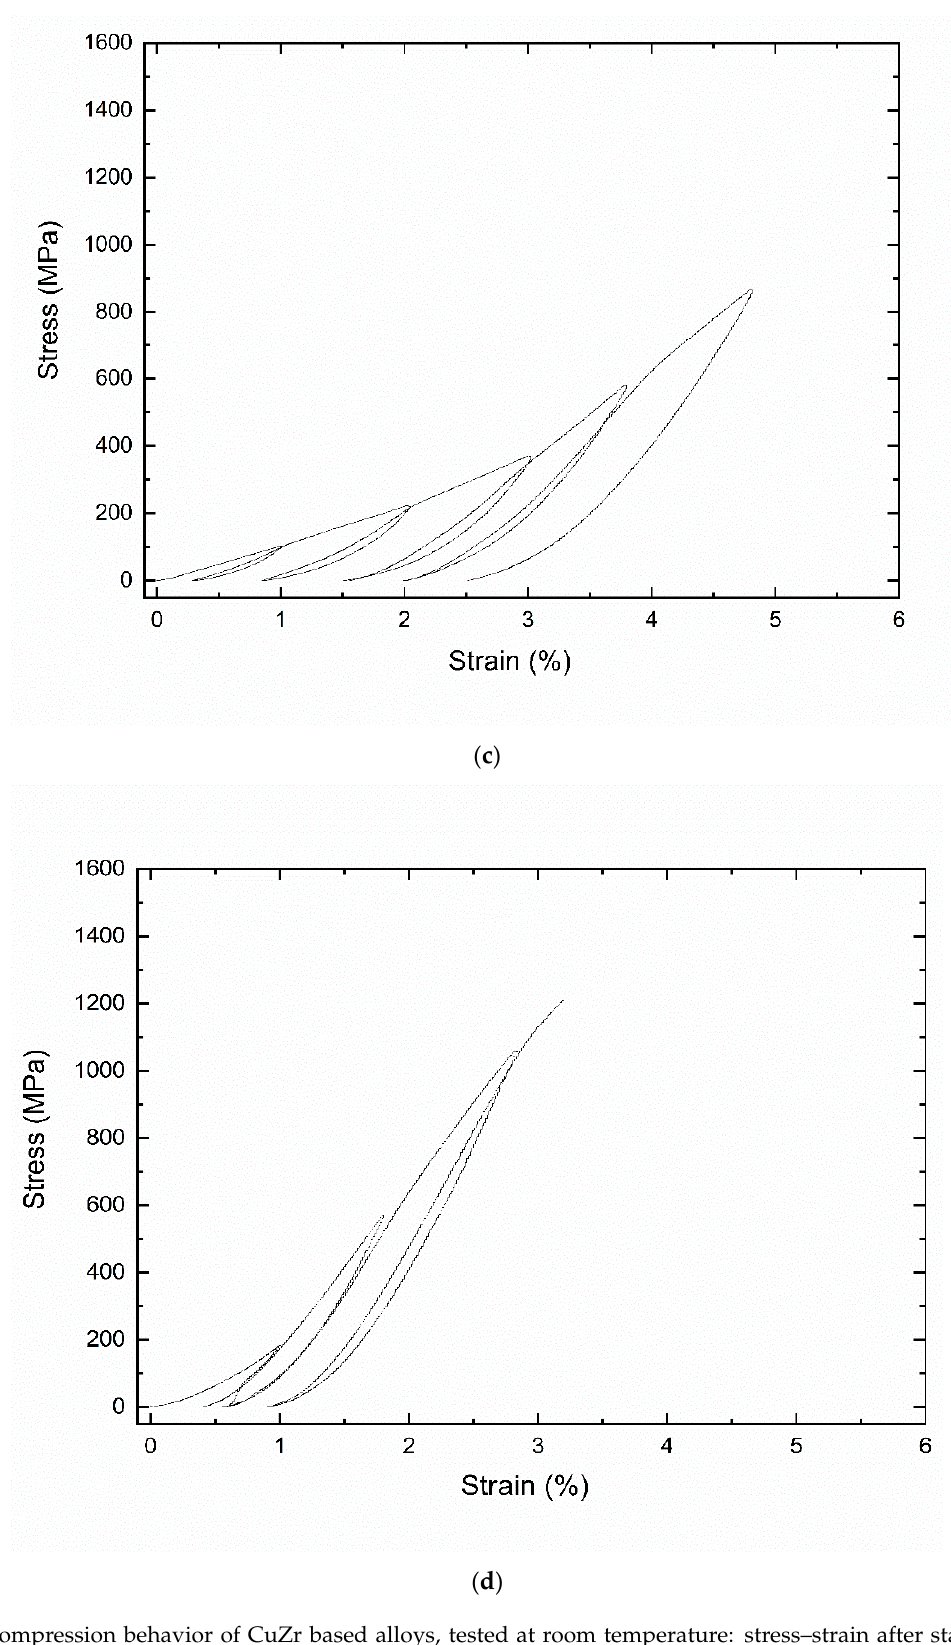
Figure 6. Compression behavior of CuZr based alloys, tested at room temperature: stress–strain after stabilization of Cu 50 Zr 50 alloy ( a ); and Cu (50 − x) Zr 50 Al x alloys with Al = 5, 10, 15 at. % ( b – d ), respectively. The stresses and strains are